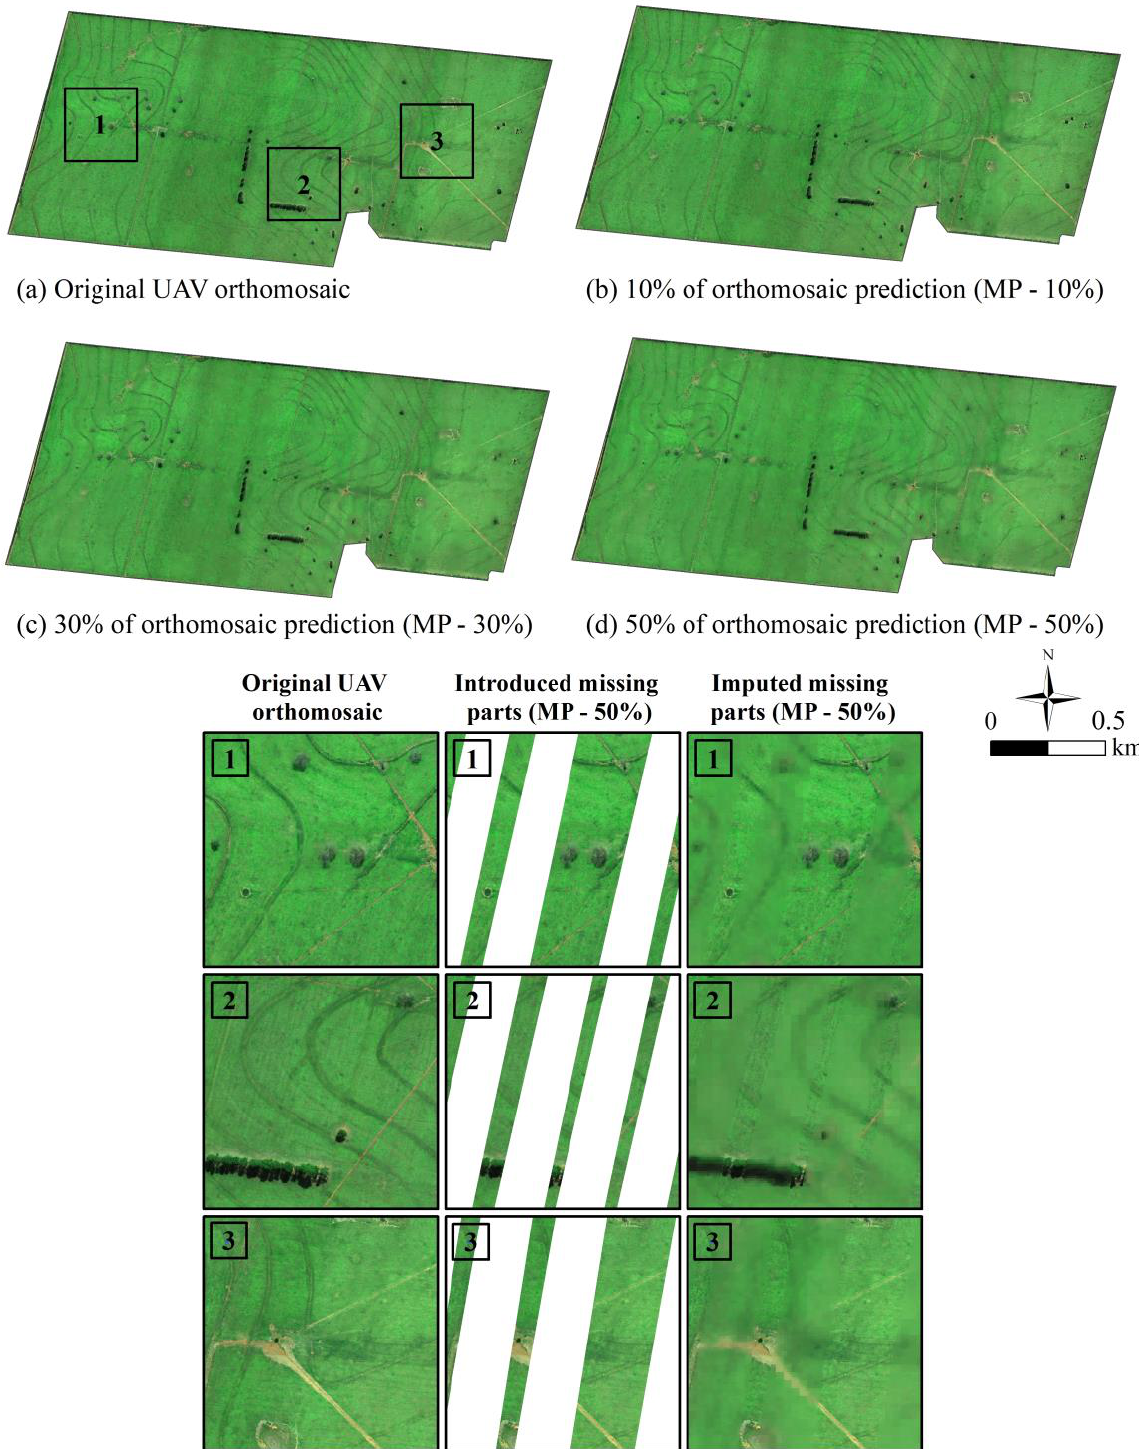
Figure 6. Comparison between the true colour composite (RGB:321) of the original UAV orthomosaic ( a ) and the imputed UAV orthomosaic — 10% ( b ), 30% ( c ), and 50% ( d ) of image prediction. Squares #1, #2, and #3 show, in more detail, the original UAV orthomosaic, the introduced missing parts, and the imputed UAV orthomosaic in the highest level of missing parts assessed in this study (MP – 50%).